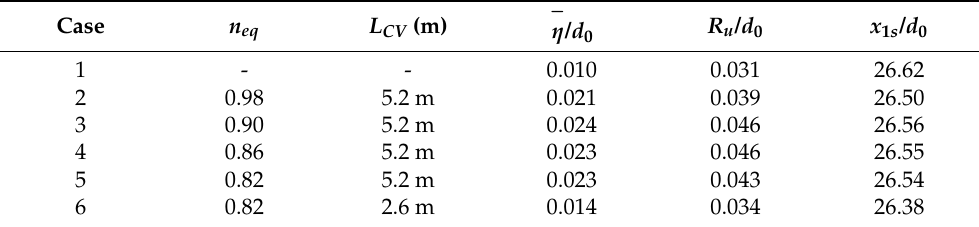
Table 3. Wave setup at the still-water coastline, η , wave runup, R u , and x 1 -coordinate of the seaward boundary of the swash zone, x 1 s